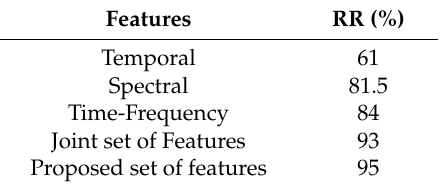
Table 6. Comparison of recognition rate achieved between the three typologies of